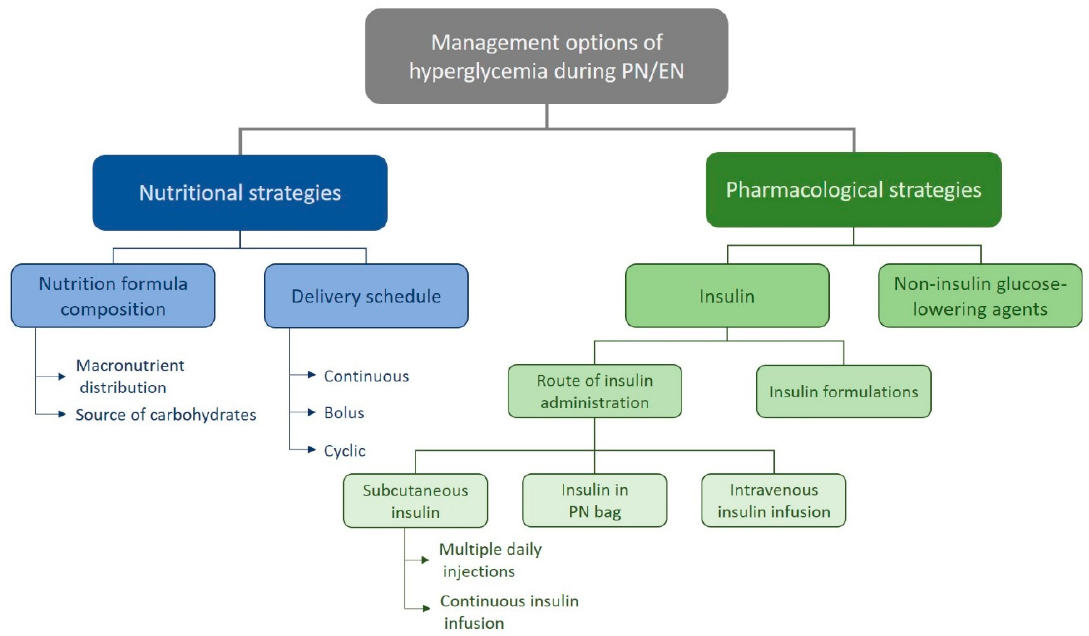
Figure 1. Management options of hyperglycemia during PN / EN. PN = parenteral nutrition, EN = enteral nutrition.